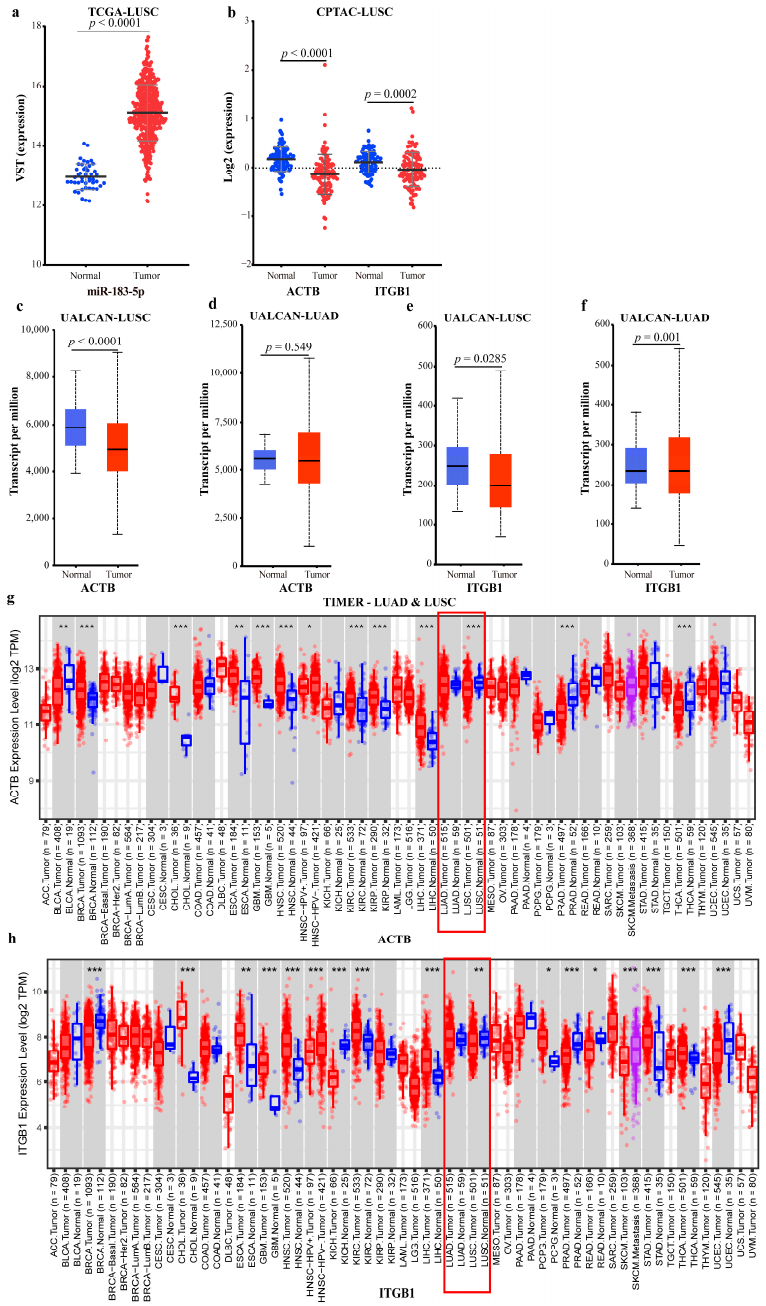
Figure 15. Expression data of miR-183-5p and target genes: ( a ) MiR-183-5p expression data in TCGA; ( b ) Proteome expression data of ACTB and ITGB1 of LUSC in CPTAC; ( c ) ACTB mRNA expression data of LUSC in UALCAN; ( d ) ACTB mRNA expression data of LUAD in UALCAN; ( e ) ITGB1 mRNA expression data of LUSC in UALCAN; ( f ) ITGB1 mRNA expression data of LUAD in UALCAN; ( g ) ACTB mRNA expression data of LUAD and LUSC in TIMER; ( h ) ITGB1 mRNA expression data of LUAD and LUSC in TIMER. The blue dots/boxs indicate the normal samples, while the red dots/boxs indicate the tumor samples. *: p < 0.05; **: p < 0.01; ***: p <